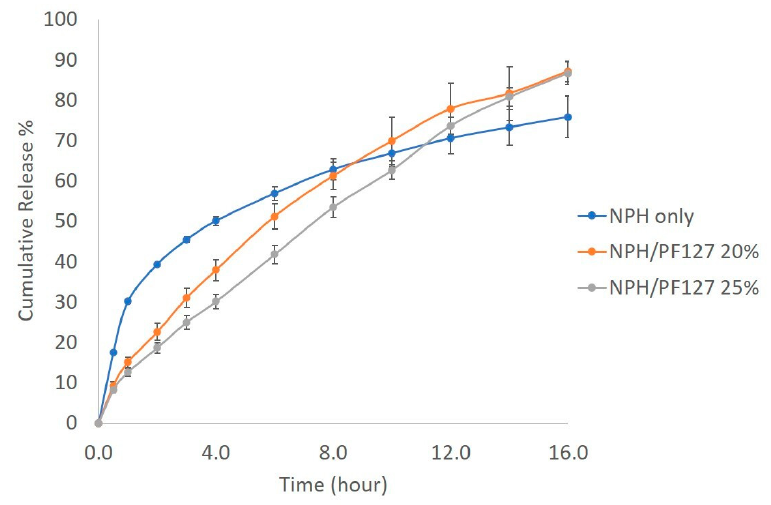
Figure 6. In vitro insulin release profile of NPH, NPH-PF127 (20%), and NPH-PF127 (25%) using PBS at pH 7.4 as a dialysis medium.